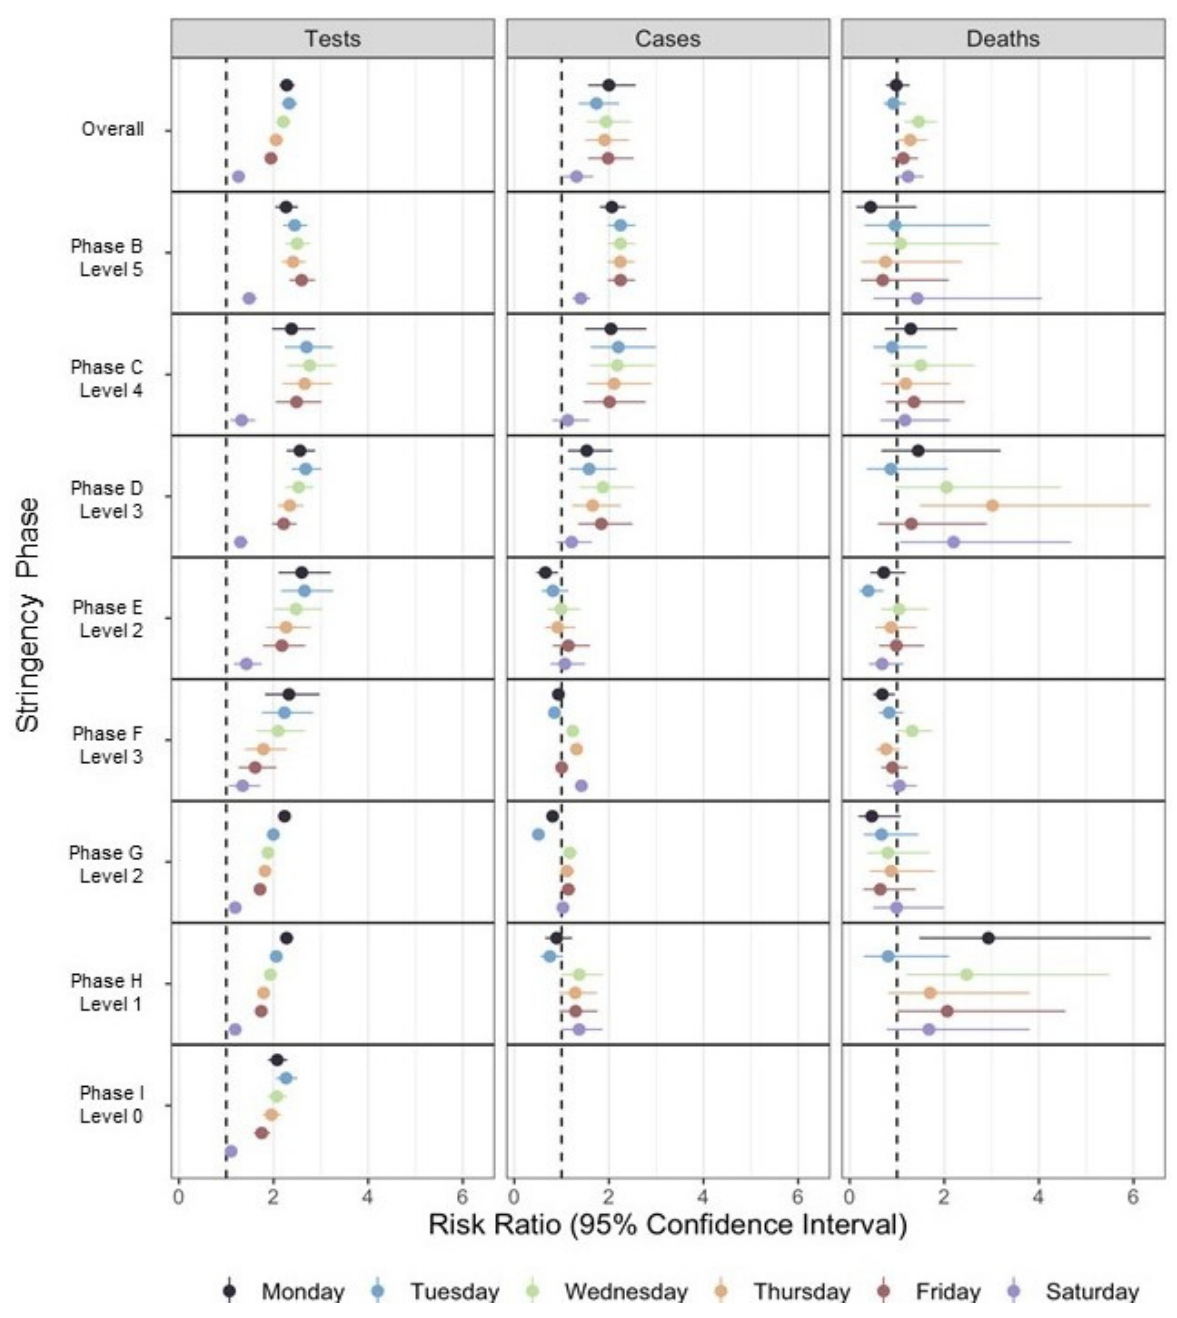
Figure 3. Shared axis, multi-panel forest plot diagrams describing day-of-the-week (DoW) effects for reported tests (left), cases (middle), and deaths (right) by Massachusetts non-pharmaceutical intervention phase. We report DoW effects for the entire study period (Overall, top panels) and by intervention phase from most historic (Phase B) to most recent (Phase I). We used embedded text to list the stringency level (ranging 0–5) for each policy phase. We estimated these effects using segmented negative binomial regression models adjusted for linear and quadratic trends in outbreak critical periods as defined by Kolmogorov-Zurbenko adaptive filters. We denote each day of the week from Monday to Saturday (Reference: Sunday). We report effects as risk ratio (RR) estimates (markers) and 95% confidence intervals (horizontal error bars) denoting RR = 1 with a vertical dashed line across all panels. We report results beginning in Phase B, as this marks the first complete phase aligning with our study period. We exclude Phase I for cases and deaths, as no weekend reporting occurred during this phase.